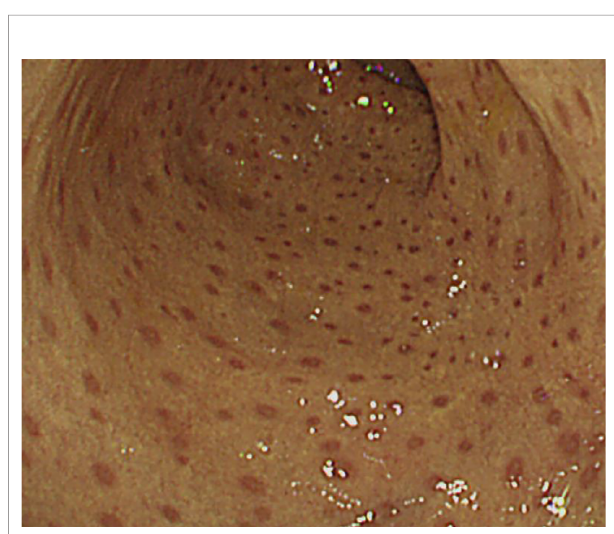
FIGURE 4 | Colonoscopic ‘ leopard sign ’ in Chronic granulomatous disease. Endoscopic view of the colonic mucosae showing the leopard sign appearing as brown dots distributed across a yellowish edematous